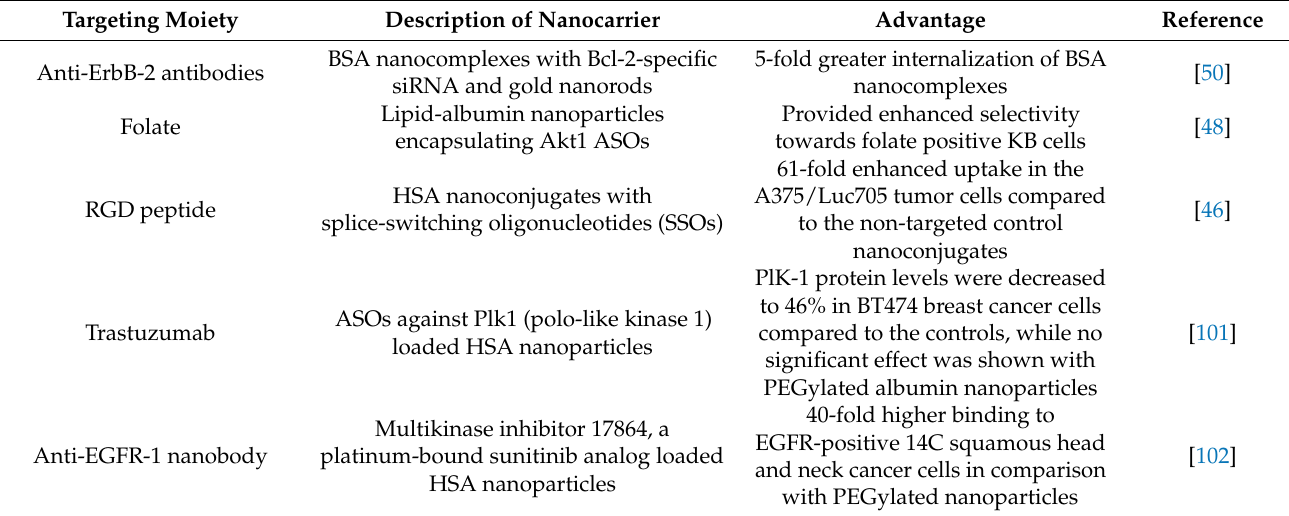
Table 2. List of albumin-based nanocarriers with targeting moieties for delivery of nucleic acids in cancer therapy. Targeting